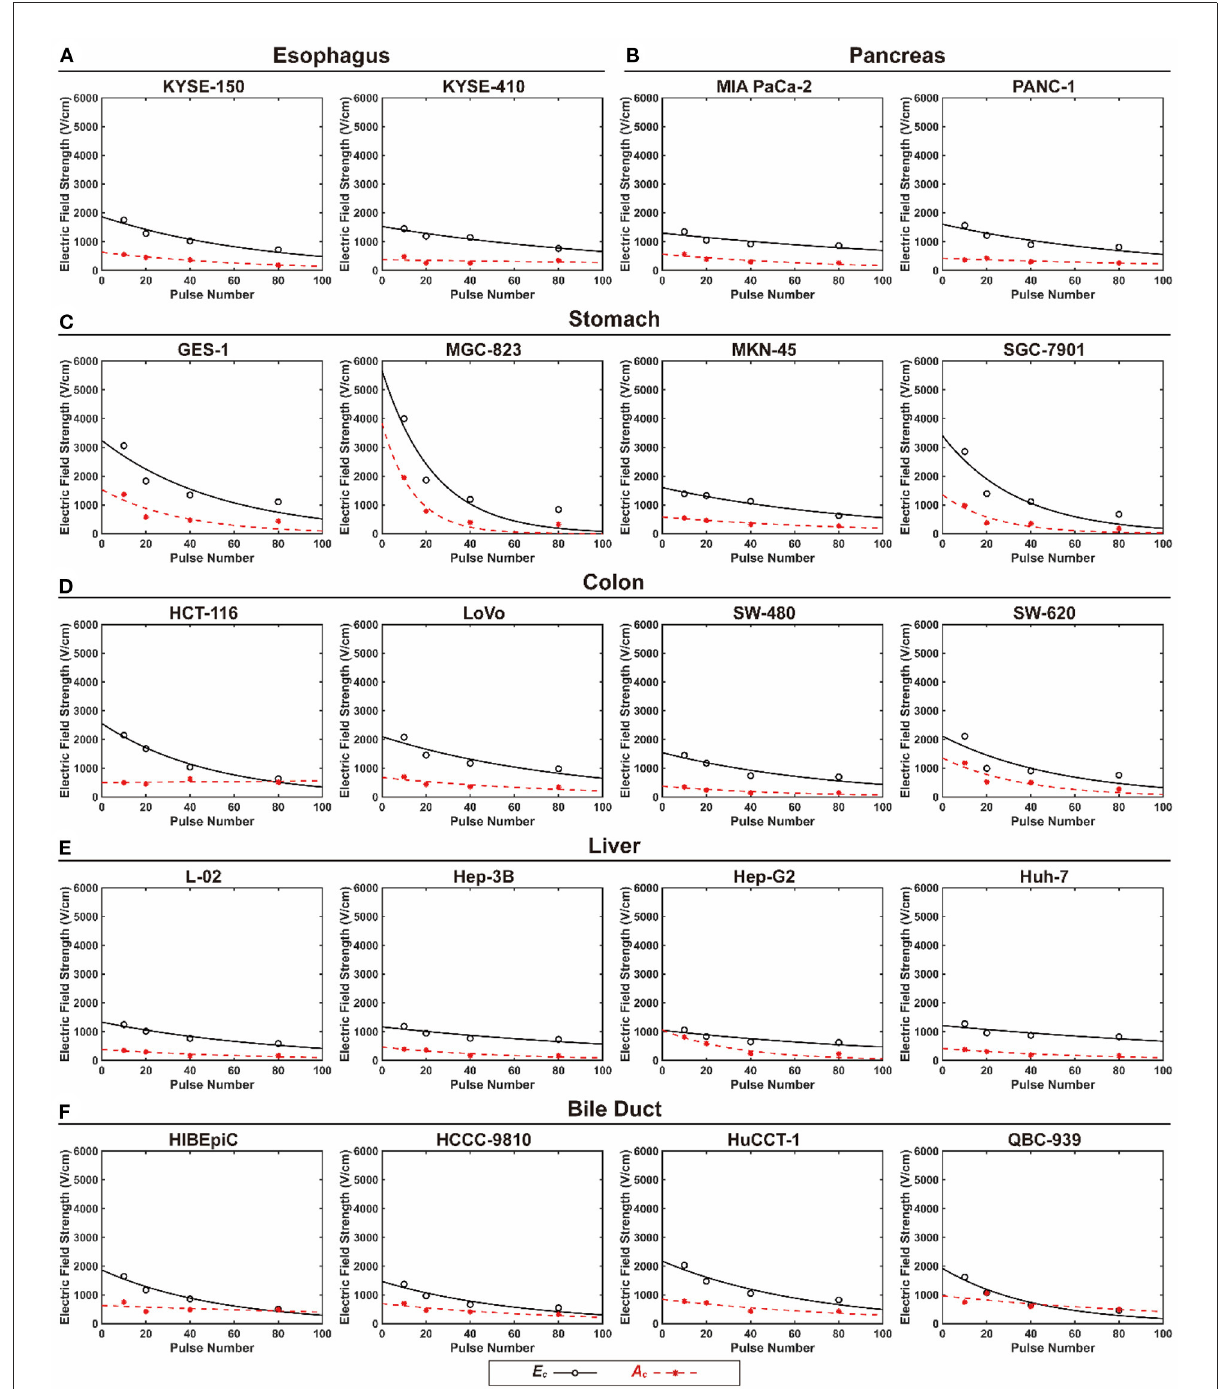
FIGURE2 The fitting curve of E c and A c for each cell lines with the increase in pulse number under 100 µ s pulse duration. (A) Esophagus, (B) pancreas, (C) stomach, (D) colon, (E) liver, and (F) bile duct.